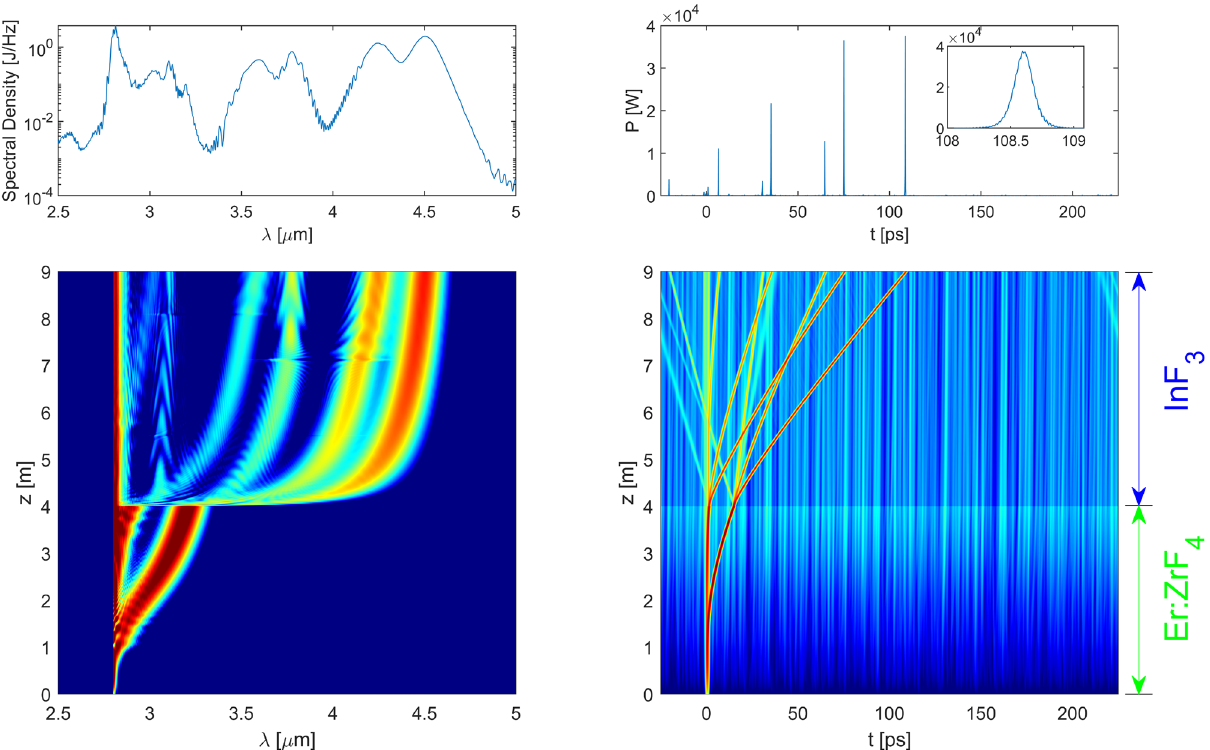
Figure 8. Propagation in the 4 m Er: ZrF 4 fiber and the 5 m InF 3 fiber. Top left: the spectrum at the output of the InF 3 fiber. Top right: the temporal signal at the output of the InF 3 fiber. Note that the pulses appear as vertical lines due to the size of the temporal window compared to the width of a single pulse. The inset is a zoom on the most shifted soliton to show its hyperbolic secant profile with a FWHM of 170 fs. Bottom left and right: evolution of the spectrum and the temporal signal along the fibers on a log scale. The spectrum was convoluted to be representative of the 2 nm resolution of the optical spectrum analyzer. The temporal signal was convoluted to broaden the soliton trajectories and make them appear more clearly (otherwise they would appear as thin lines barely visible on the